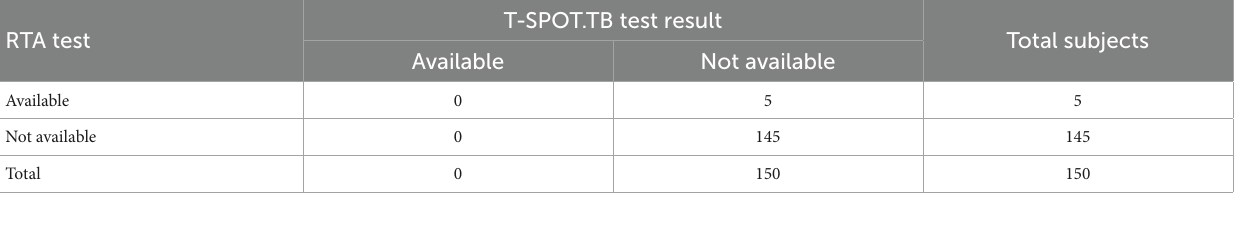
TABLE 6 Confusion matrix.